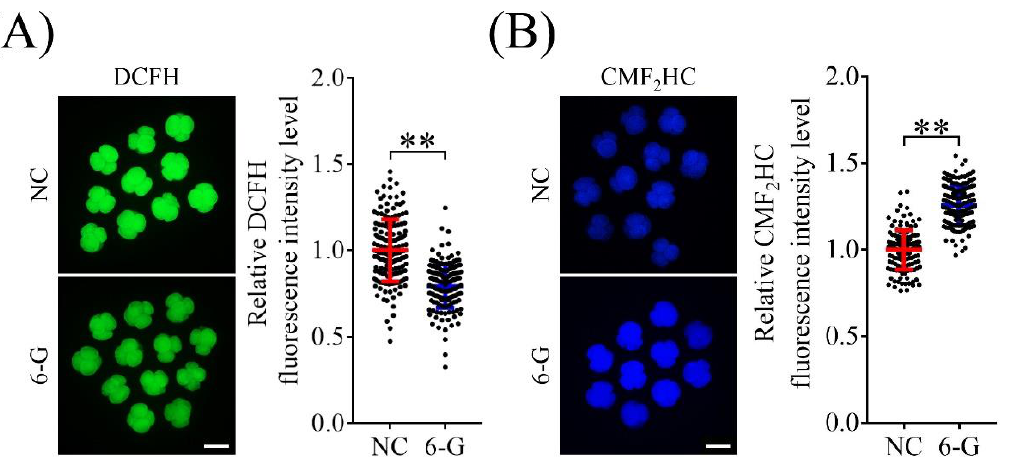
Figure 4. Effects of 6-gingerol (6-G) on reactive oxygen species (ROS) and glutathione (GSH) levels. ( A ) Representative 2 (cid:48) ,7 (cid:48) -dichlorodihydrofluorescein diacetate (DCFH) staining images of 4-cell-stage embryos with or without 6-G. The relative DCFH fluorescence intensity decreased significantly in 4-cell-stage embryos with 6-G. R = 5. Bar = 100 µ m. ( B ) Representative 4-chloromethyl-6,8-difluoro- 7-hydroxycoumarin (CMF 2 HC) staining images of 4-cell-stage embryos with or without 6-G. The relative CMF 2 HC fluorescence intensity increased significantly in 4-cell-stage embryos with 6-G. R = 5. Bar = 100 µ m. ** p < 0.01.